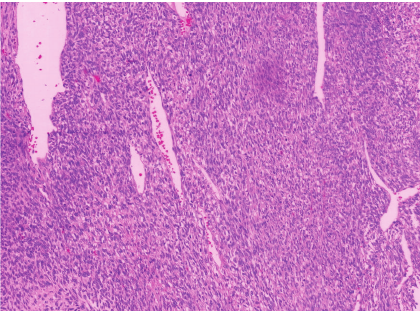
Figure 2: Staghorn vascular structures, similar to the hemangioper- icytoma, are seen (H&E 10x).